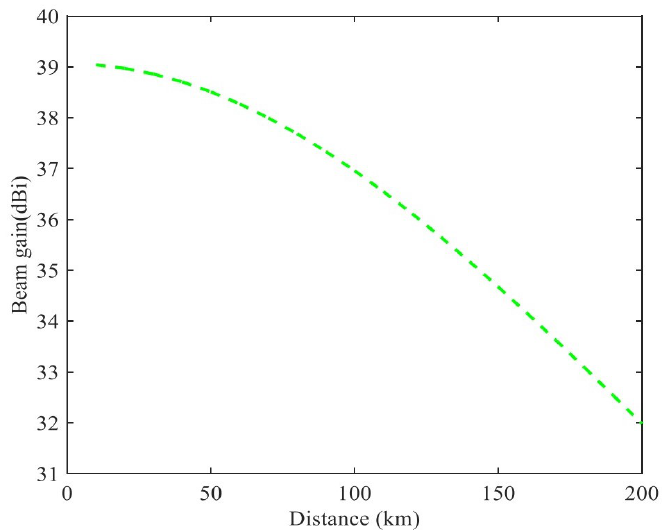
Figure 3. Relationship between beam gain and